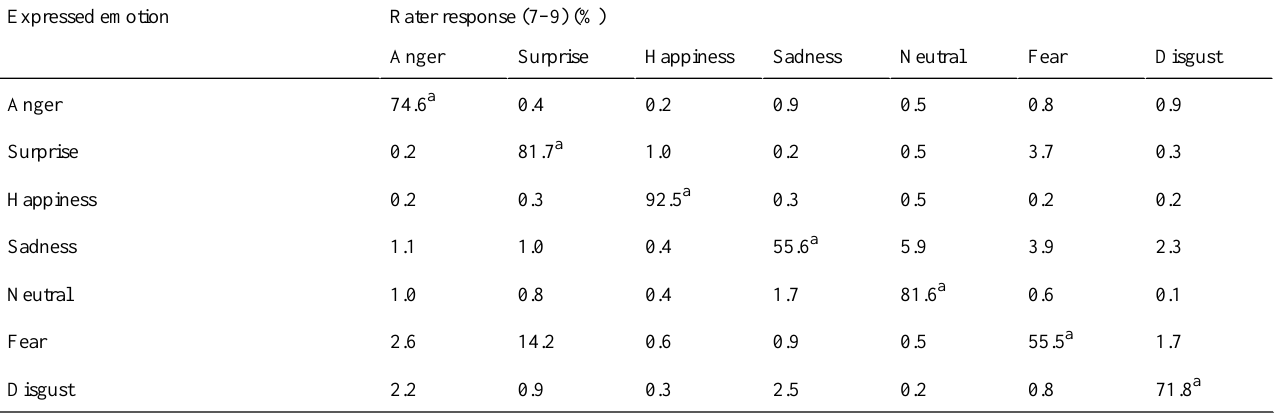
Table 2. Confusion matrix for images of expressed emotion and rater response (only scores 7–9